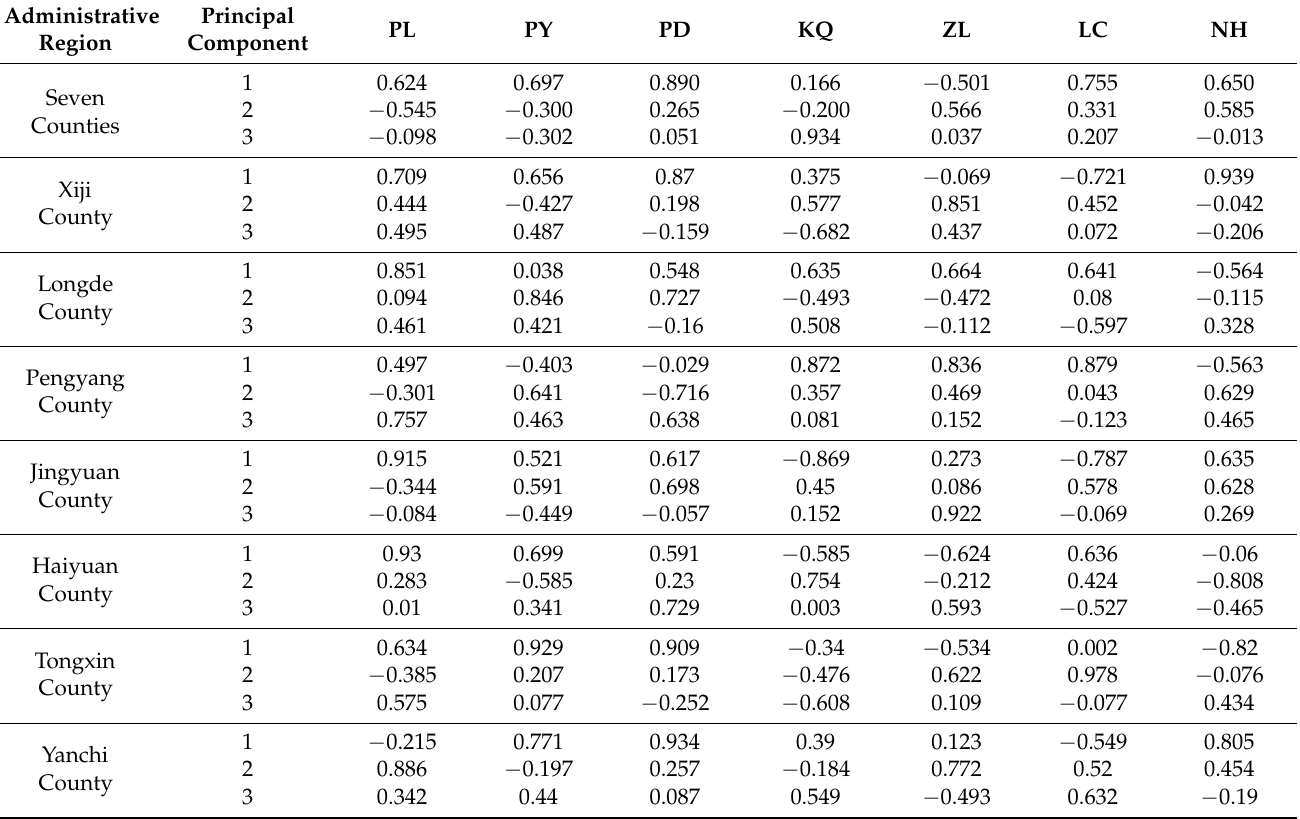
Table 3. Principal component matrix of the environmental quality index system of each administrative